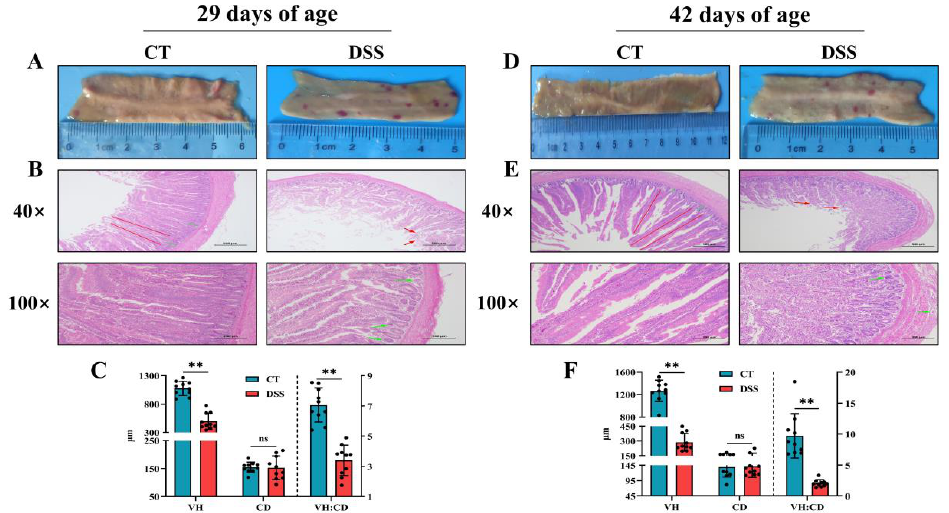
Figure 4. Effects of oral gavage of DSS on the jejunal lesion and morphology in broilers: ( A ) image of jejunum gross lesions at 29 days of age; ( B ) jejunal morphology by HE staining at 29 days of age; ( C ) VH, CD, and VH:CD of jejunum at 29 days of age (n = 10 per group); ( D ) image of jejunum gross lesions at 42 days of age; ( E ) jejunal morphology by HE staining at 42 days of age; and ( F ) VH, CD, and VH:CD of jejunum at 42 days of age (n = 10 per group). Values are means ± SD. ** p < 0.01; ns: not significant ( p > 0.05). Red line, villus height; Green line, crypt depth; Red arrow, tissue disrup- tion; Green arrow, inflammatory cell infiltration. VH: villus height; CD: crypt depth; VH:CD: ratio of villus height to crypt depth. CT = control; DSS = treated. 3.4. Effect of Oral Gavage of DSS on Intestinal Development To determine the short- and long-term effects of oral gavage of DSS on intestinal de- velopment, we measured the length, weight, and length-to-weight ratio in different intes- tinal segments at two time points. At 29 days of age, the length of the jejunum and cecum in the CT group was higher than that in the DSS group ( p < 0.05) (Figure 5A). In addition, there were no differences observed in intestinal development ( p > 0.05) (Figure 5B ‒ F).